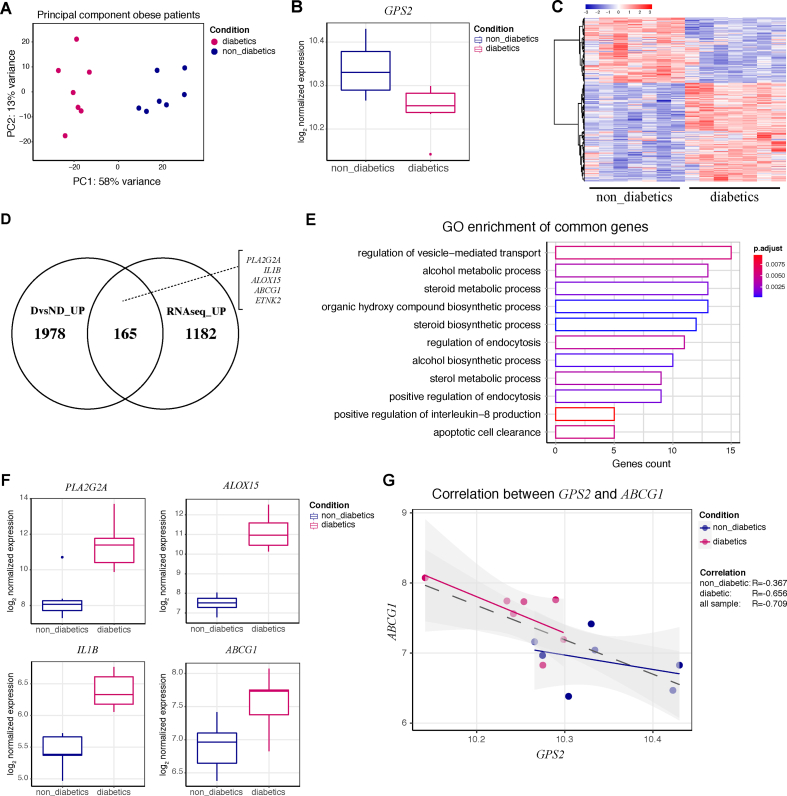
Correlations of GPS2 expression with ABCG1 expression, diabetic status, and lipid management in omental adipose tissue of obese patients. (A) Principal component (PC) analysis of transcriptome data from obese patients grouped by type 2 diabetic status (n = 7 obese non-diabetic and n = 7 obese diabetic). (B) Box plot representing log2 normalized GPS2 expression in non-diabetic and type 2 diabetic obese patients (n = 7 obese non-diabetic and n = 7 obese diabetic). (C) Heatmap of significantly changed ( p-value < 0.05 and LogFC > 0.5 or LogFC < −0.5) gene expression in non-diabetic vs diabetic obese patients (n = 7 obese non-diabetic and n = 7 obese diabetic). (D) Venn diagram representing the commonly upregulated genes (diabetic vs non-diabetic patients) and hMADS cells (shGPS2 vs shGFP). (E) Gene ontology enrichment of the 165 commonly upregulated genes shown in (D). (F) Box plot representing log2 normalized expression of PLA2G2A, ALOX15, IL1B, and ABCG1 in non-diabetic vs diabetic obese patients (n = 7 non-diabetic and n = 7 diabetic). (G) Correlation analysis of GPS2 with ABCG1 mRNA levels in human obese omental adipose tissue (n = 7 non-diabetic and n = 7 diabetic).